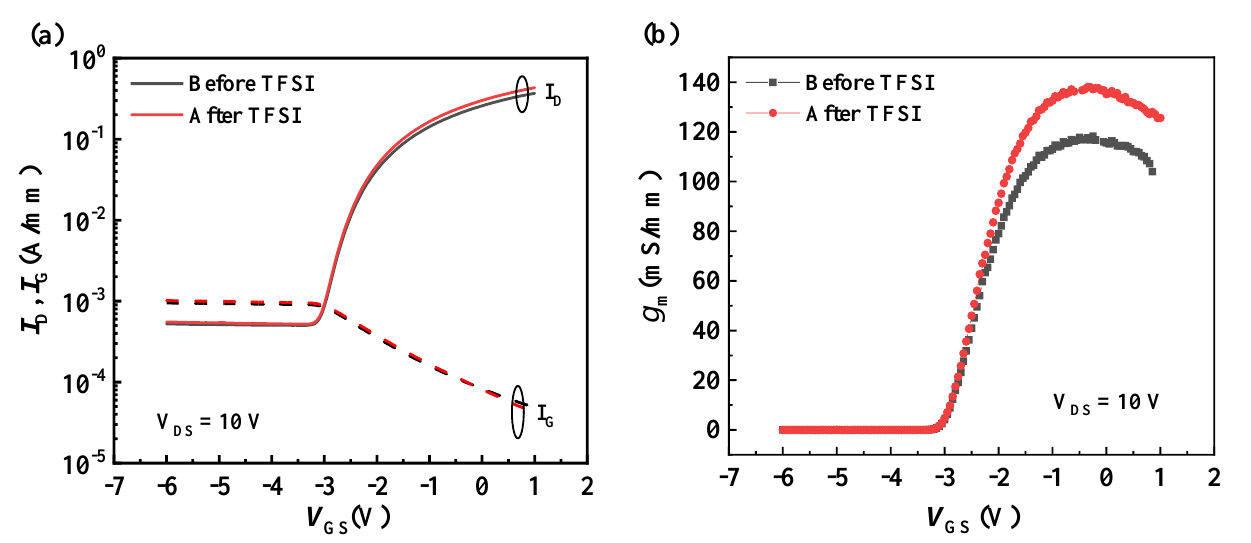
Figure 4. ( a ) Transfer characteristics in log-scale at V DS = 10 V of InAlN/GaN HEMT before and after TFSI treatment; ( b ) Transconductance at V DS = 10 V of InAlN/GaN HEMT before and after TFSI treatment.